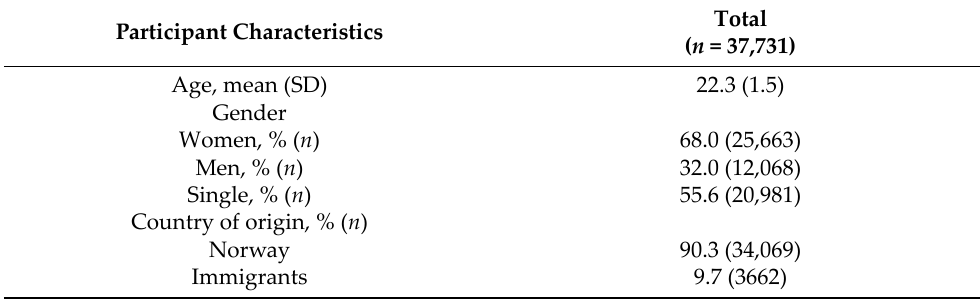
Table 2. Sociodemographic characteristics of the study sample.